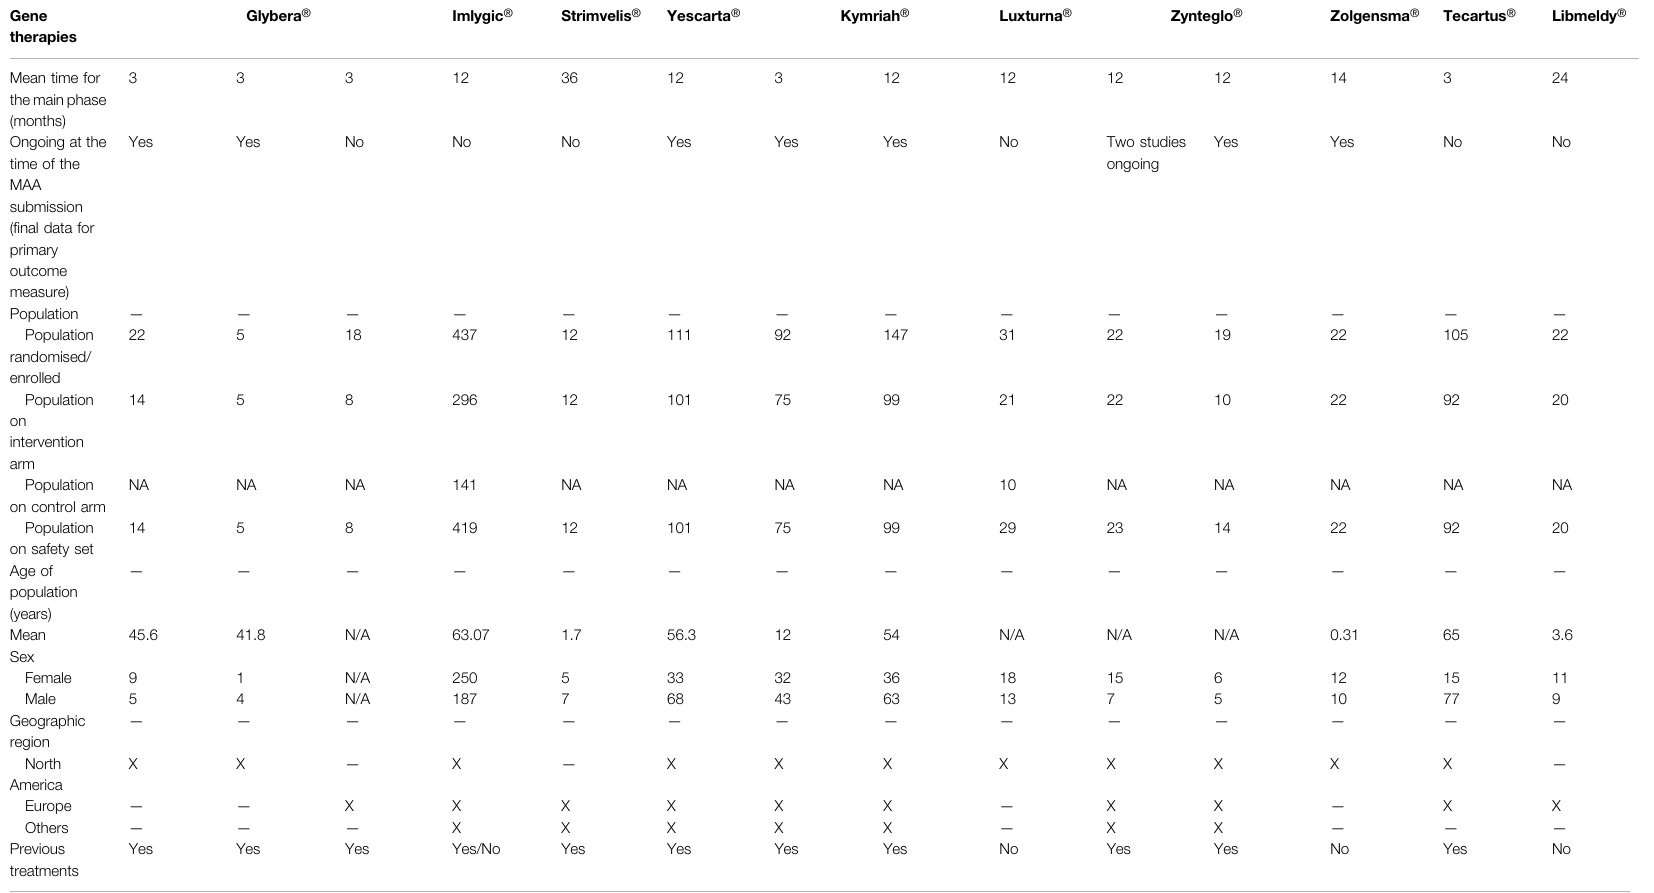
TABLE 3 | ( Continued ) Design features of pivotal clinical trials for the approved gene therapy medicinal products in the European